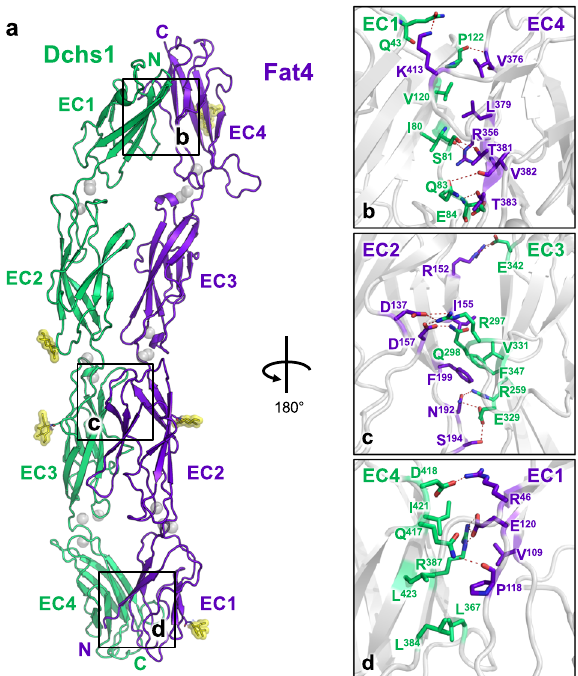
Fig. 2 | Structure of the Fat4:Dchs1 complex. a Crystal structure of Fat4(EC1 – 4) bound to Dchs1(EC1 – 4) in cartoon representation. N-linked glycans are colored yellowand Ca 2+ ions are depictedasgrayspheres. b – d . Zoom panelsdepicting the Fat4(EC4):Dchs1(EC1) interface ( b ),the Fat4(EC2):Dchs1(EC3)interface ( c ),and the Fat4(EC1):Dchs1(EC4) interface ( d